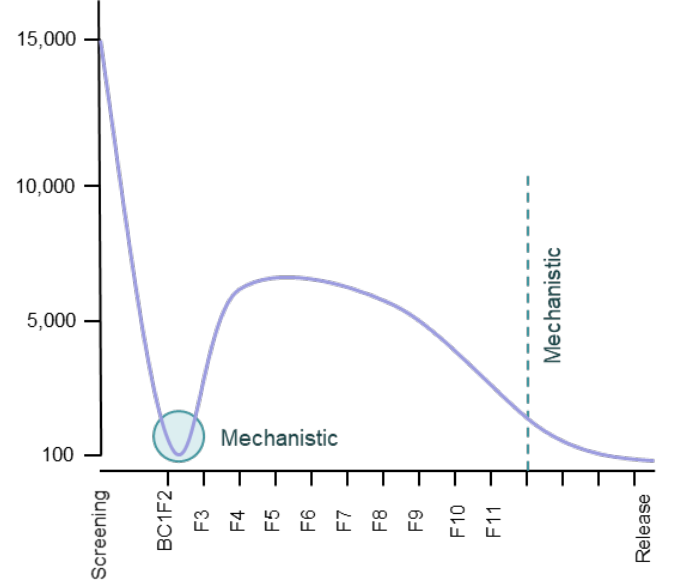
Figure 1. Typical numbers of rice plants at successive stages of IRRI’s breeding pipeline (data from 2009–2015). Initial screening of varieties and landraces identified a limited number of genotypes with resistance to planthoppers and leafhoppers. These were then integrated into the breeding program together with genotypes possessing other desirable traits (<100 genotypes). Crossing increases the number of plants that require screening. At an estimated cost of $1 per line, bulk tests are rec- ommended for screening and early generations such as back cross F2 (BC1F2) and F3-F11 genera- tions. Mechanistic research is recommended for donor varieties/landraces, at post-F11 generations and at pre-release (graph and cost estimates are based on unpublished data from Horgan and Alma- zan).